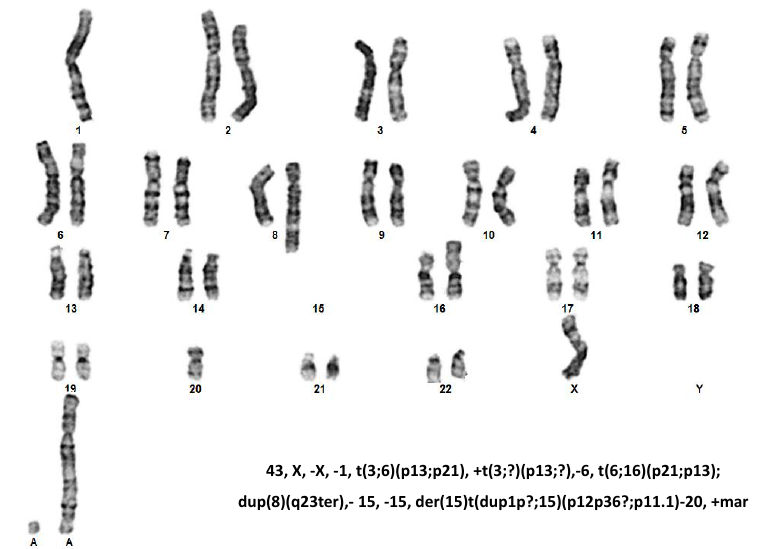
Figure 2. Karyotype of BI-ALCL #3.